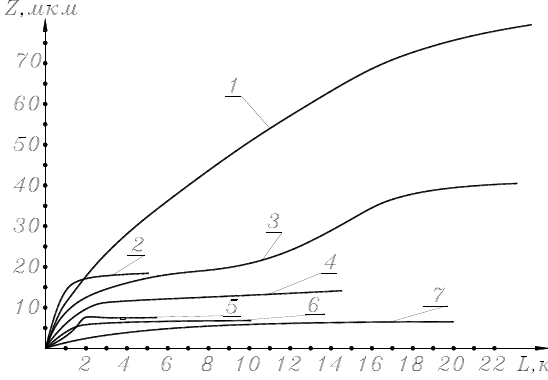
Fig. 5. Wear samples of nitrided steel 45 depending on the path at pressure in the contact zone and sliding speed: 1-65 MPa, 0.1 m/s; 2 – 50 MPa, 0.1 m/s; 3 – 120 MPa, 0.1 m/s; 4 – 80 MPa, 0.1 m/s; 5 – 40 MPa, 0.3 m/s; 6 – 65 MPa, 0.2 m/s; 7 – 20 MPa, 0.2